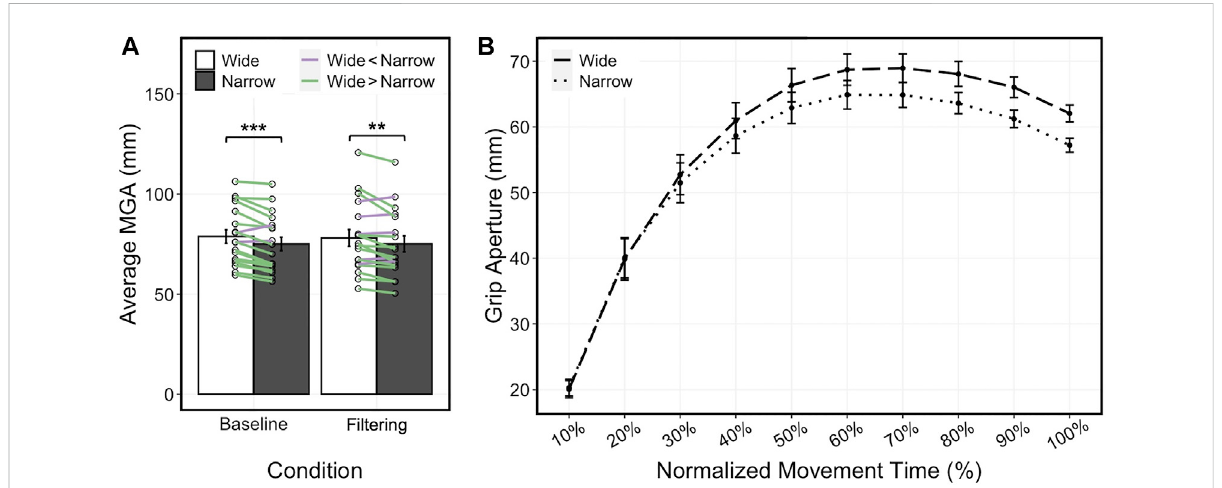
FIGURE 5 (A) Sensitivity to object width size was found for both baseline (t 17 = 4.65, p < 0.001) and fi ltering (t 17 = 3.01, p = 0.008) conditions, with larger MGAsforthewidewidthcomparedtothenarrowwidth.PurplelinesrepresentindividualswithaverageMGAgreaterwithnarrowwidthcomparedto wide width and green lines represent individuals with average MGA greater with wide width compared to narrow width. (B) Average grip aperture across the movement trajectory. After normalizing movements into 10 time points, movement trajectories were averaged for narrow and wide widthrectangularobjectsandcollapsedacrossconditions.Maximumgripaperturereachedapeakataround70%ofthemovementtime,resembling movement trajectories toward real 3D objects. Error bars represent standard error. p < 0.01**, p <